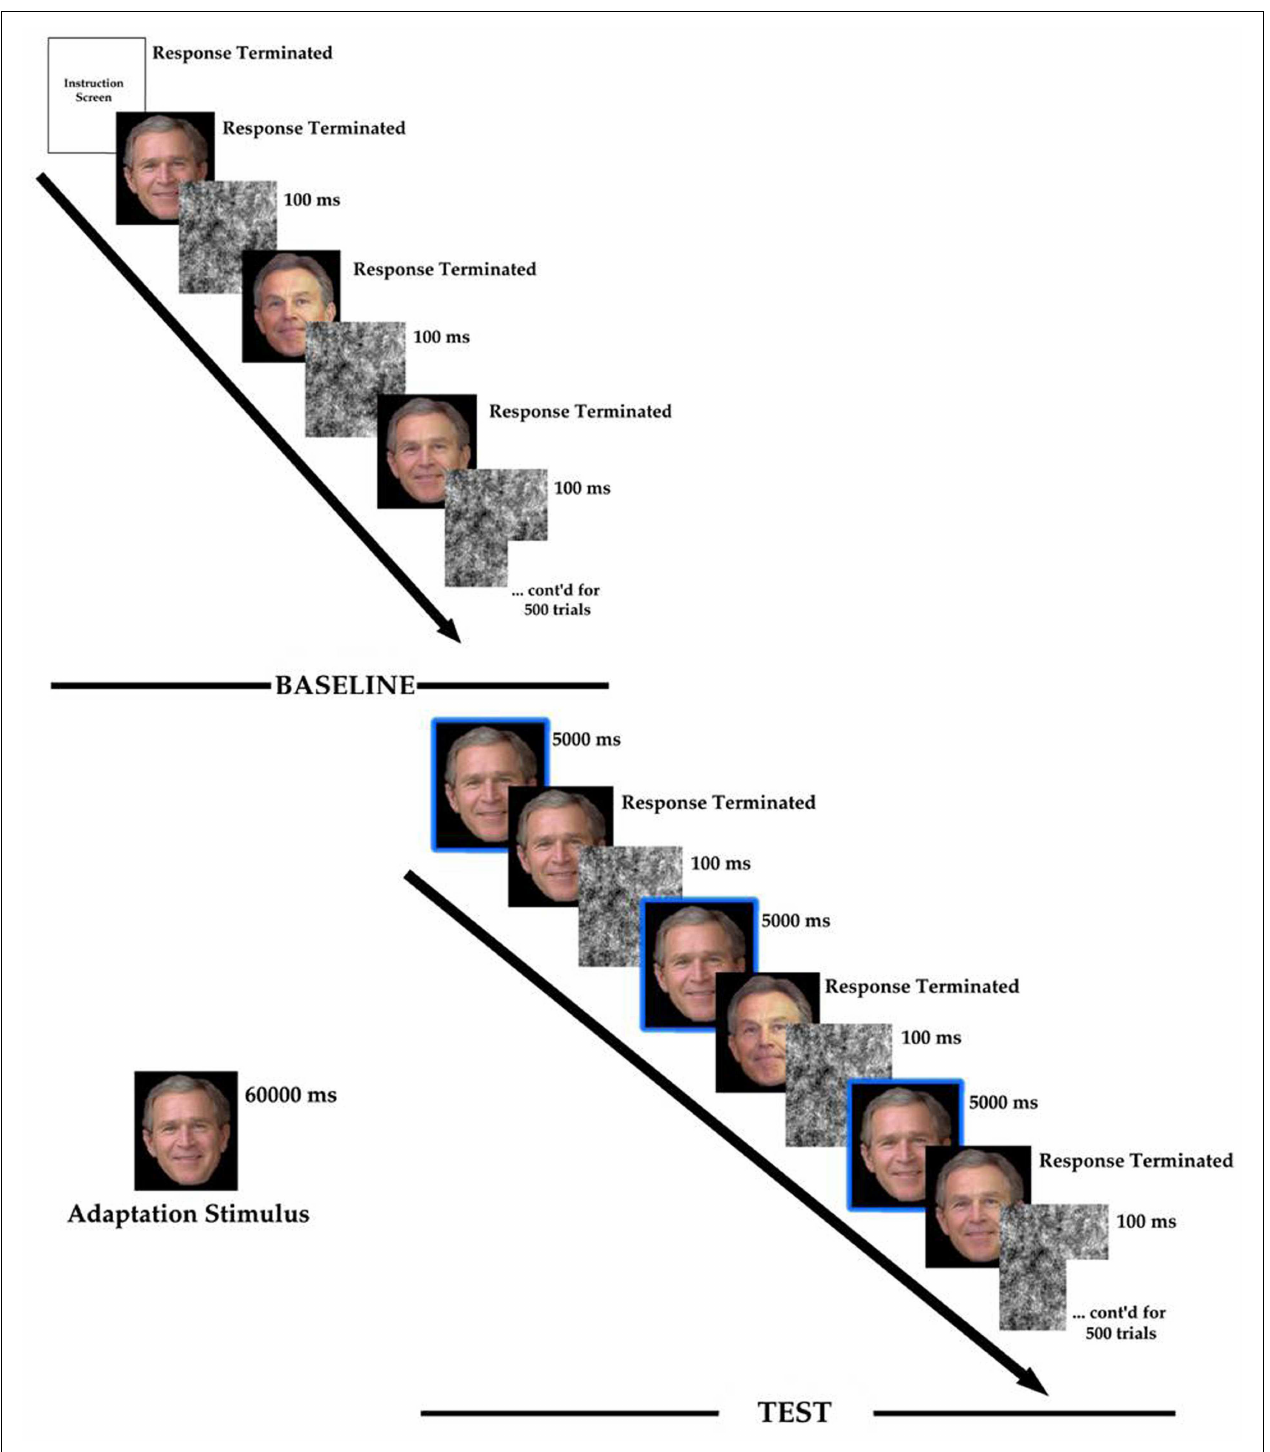
FIGURE 2 |The procedure for the experimentation. Those surrounded by the box are the adaptor repeated during the test phase.